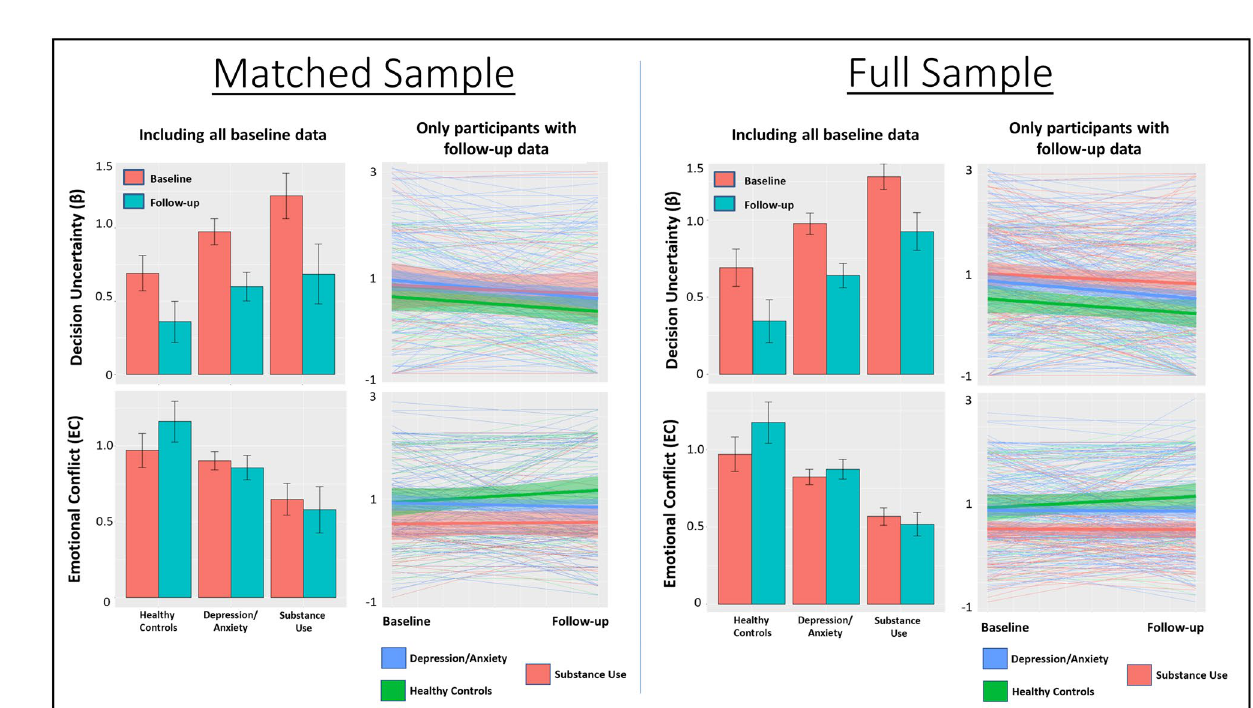
Figure 3. Means and standard errors for model parameters by clinical group and time in both the propensity matched and full samples. Bar graphs include baseline participant values both with and without follow-up data. Spaghetti plots only include participants with both baseline and follow-up data (thick lines indicate group means, surrounding shading indicates standard error). Comparison of bar graphs and spaghetti plots illustrates that relative differences between groups were somewhat more consistent between baseline and follow-up when including all baseline